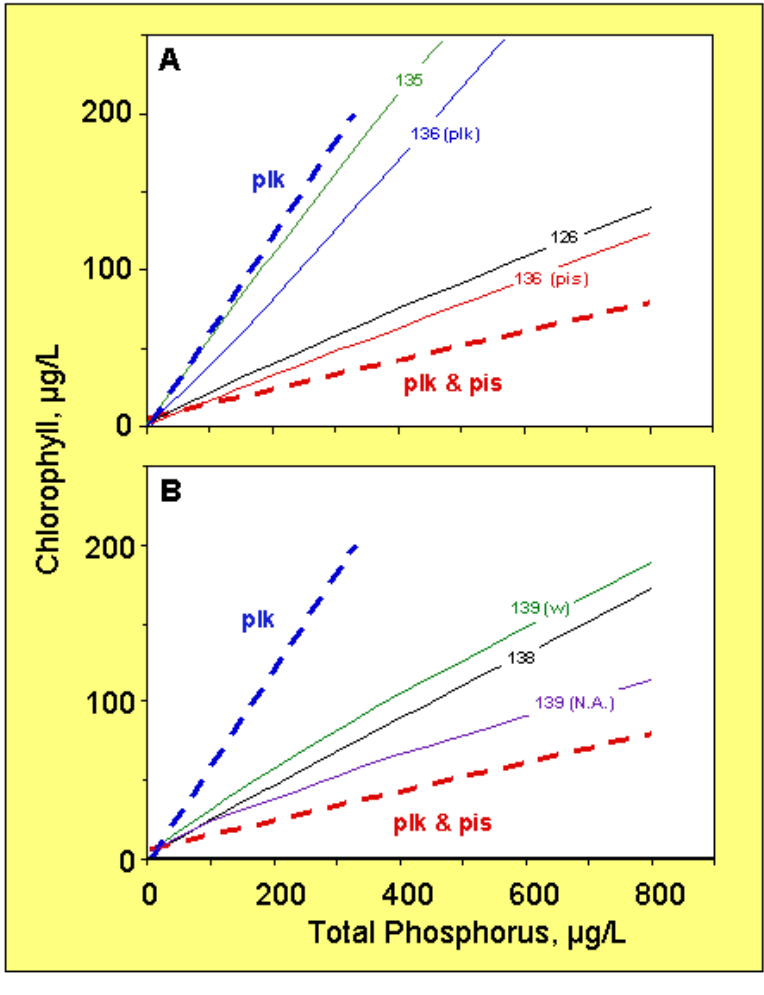
FIGURE 5. Comparison of chlorophyll–total phosphorus relationship in systems containing planktivorous fish with ( red dashed line) and without ( blue dashed line) piscivorous fish (from Fig. 4) to previously published chlorophyll–total phosphorus relationships. The numbers on the graph lines denote the literature reference number. (A) The green line is from Mazumder[135] for systems containing only planktivorous fish. The black line is from Currie et al.[126] for systems with and without piscivores. The remaining lines are from Quiros[136] for Argentine lakes and reservoirs containing only planktivorous fish ( blue line) and both planktivorous and piscivorous fish ( red line). (B) G reen and purple lines are from Nurnberg[139] for World and North American lakes and reservoirs; the black line is from OECD[138]. Note that all regression lines have been extended to the range for data shown in Fig.